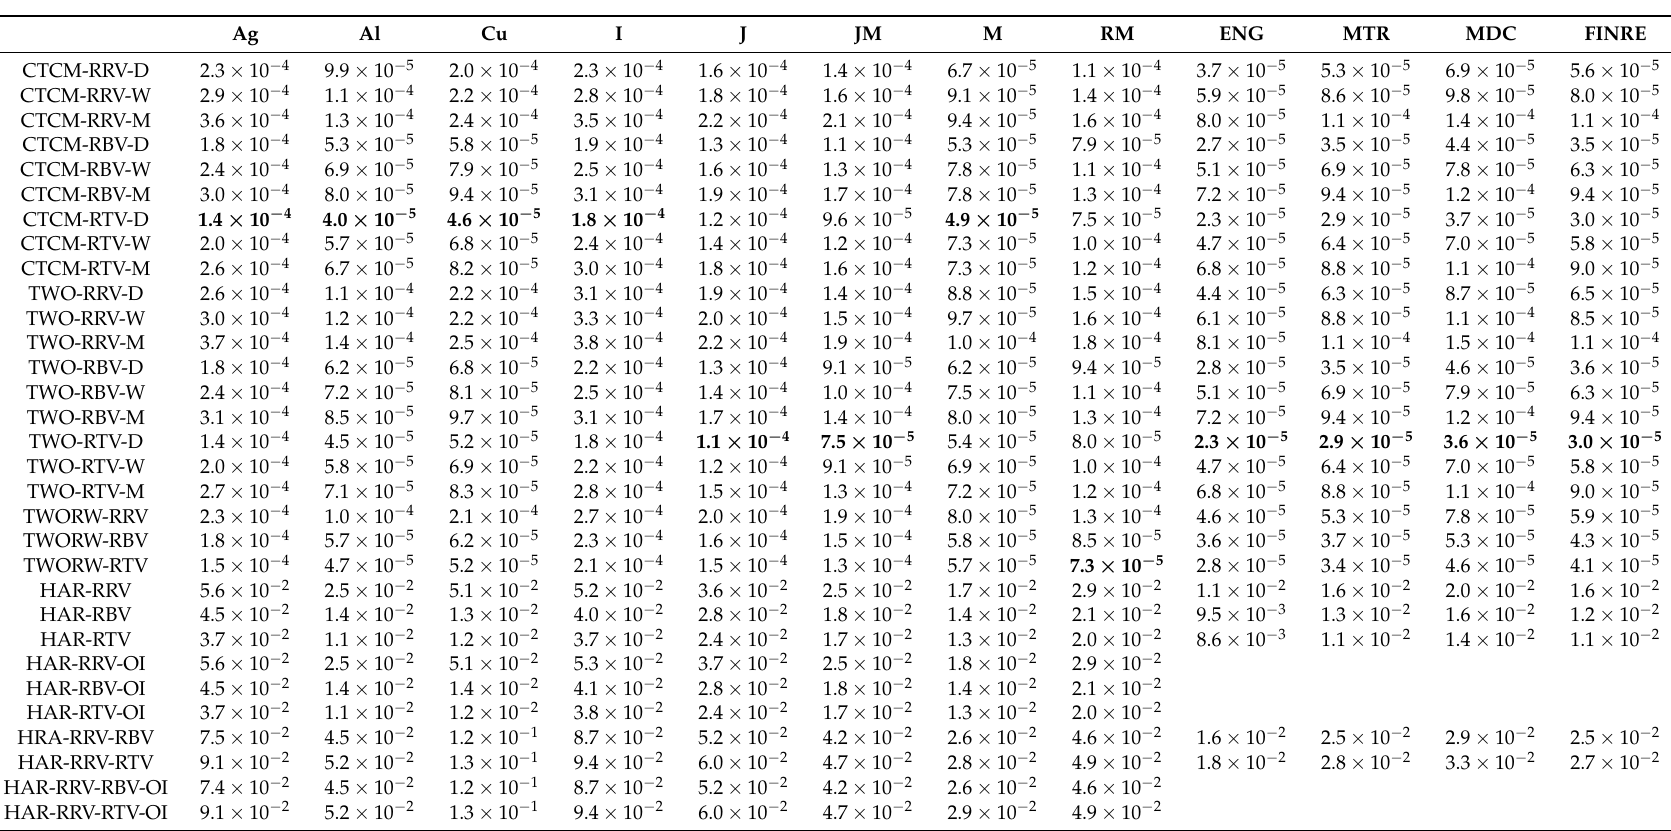
Table 6. The results of out of sample forecast